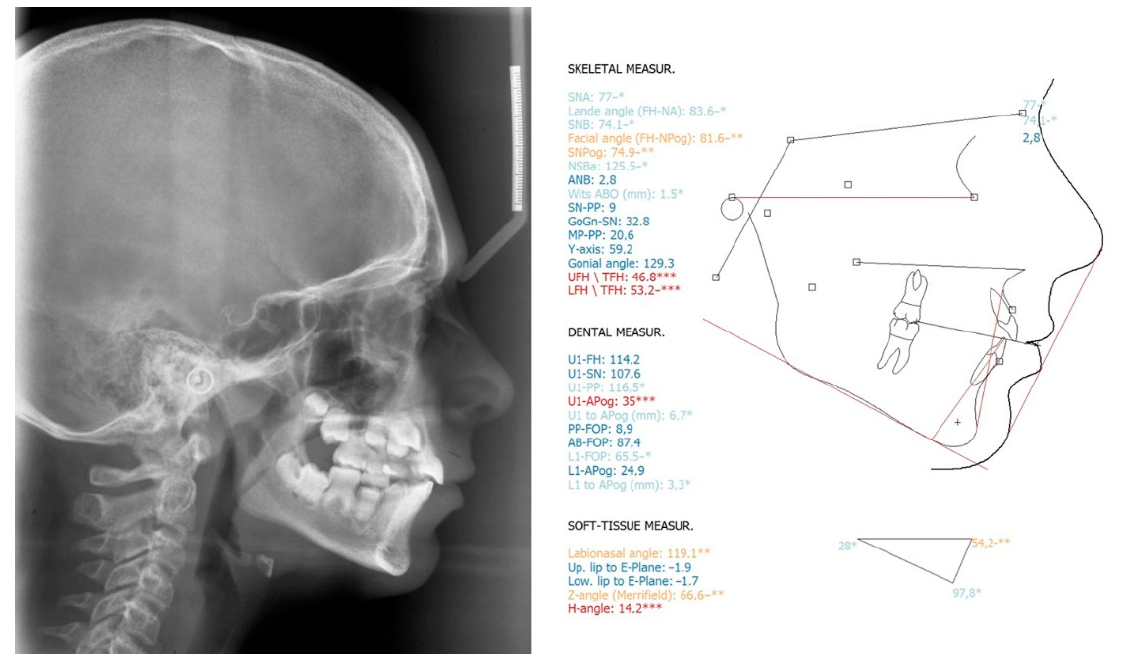
Figure 4. Pre-treatment lateral cephalometric radiograph and cephalometric analysis. *: ±1 Standard Deviation from the norm (light blue), **: ±2 Standard Deviations from the norm (orange), ***: ±3 Standard Deviations from the norm (red).